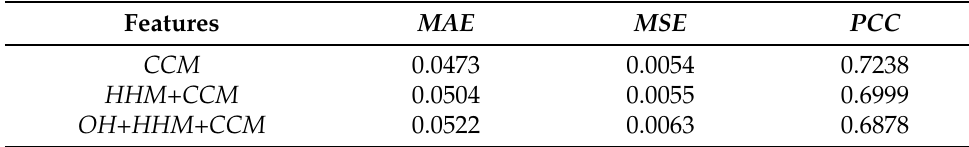
Figure 3. The changes of Loss , MAE , and PCC on SurTrain and SurValid, respectively. Table 5. Performance of TMP-SurResD on